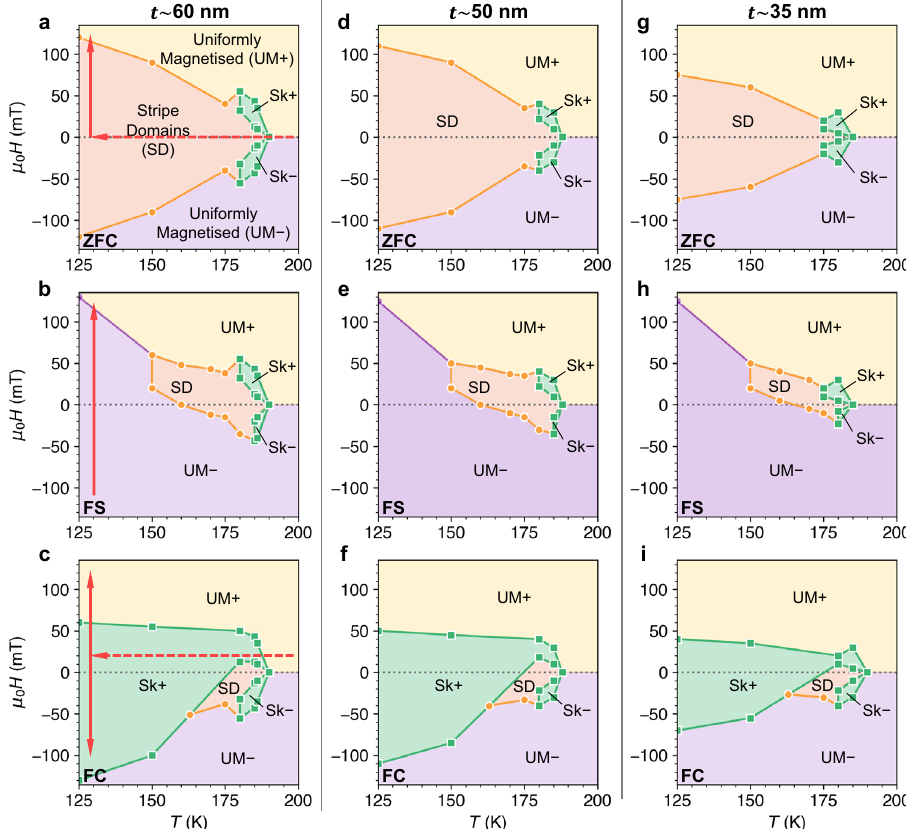
Fig. 2 History and thickness dependent magnetic phase diagrams. Magnetic phase diagrams determined by imaging the Fe 3 GeTe 2 (FGT) fl ake as a function of temperature and applied fi eld for three different thickness regions: 60 nm ( a – c ), 50 nm ( d – f ) and 35 nm ( g – i ). Phase diagrams were determined by following the zero fi eld cooling (ZFC) ( a , d , g ), fi eld sweep (FS) ( b , e , h ), or fi eld cooling (FC) at 15 mT ( c , f , i ) measurement procedures. The measurement paths are indicated by the red arrows in a – c . The existence of the stripe domain (SD, orange), skyrmion (Sk± , green) and uniformly magnetised (UM + , yellow, UM − , purple) states are indicated by the coloured regions. Measured boundary points are indicated by the markers (orange circles for SD, green squares for Sk